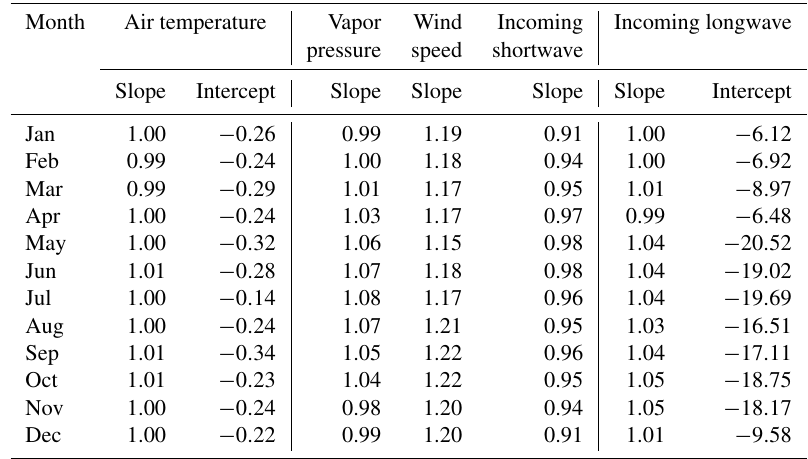
Table 5. Monthly regression results for Peyto Main and Peyto Main Old hourly